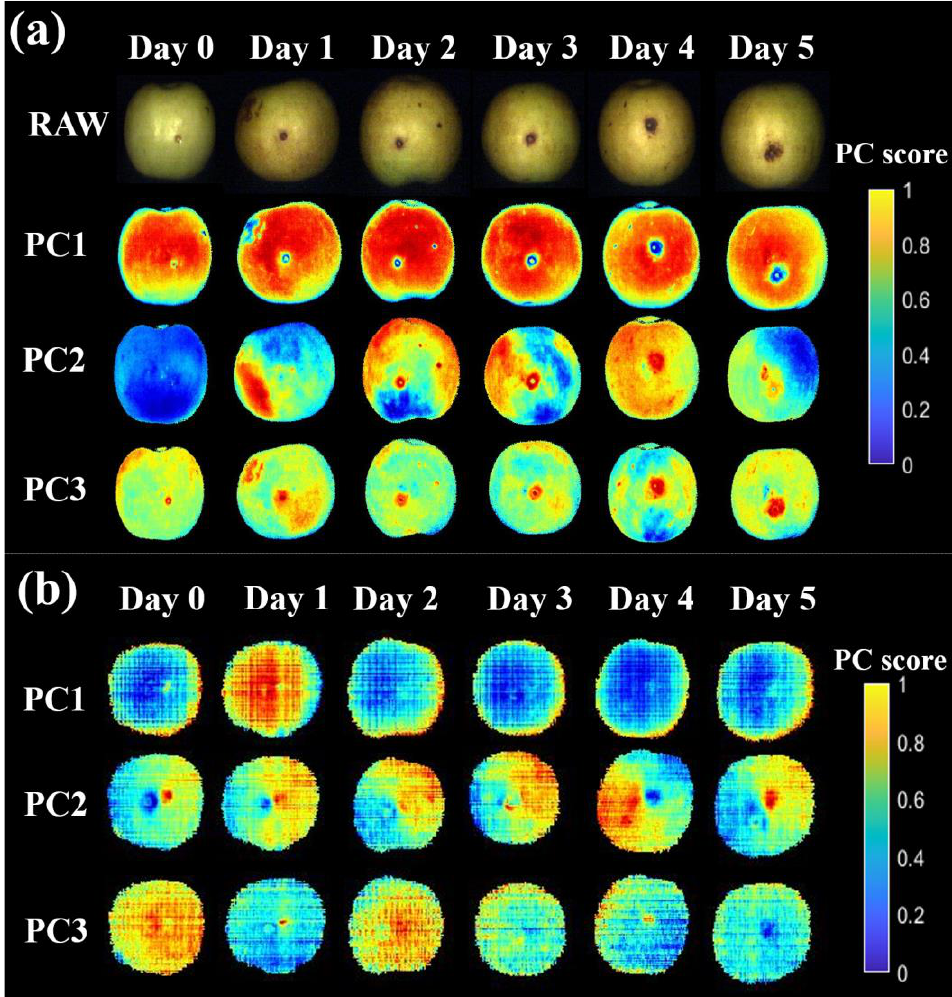
Figure 5. Raw and pseudo-color images based on PC scores of the inoculated fruit at different infection stages in the range of ( a ) 400 – 1000 nm and ( b ) 1000 – 2000 nm.